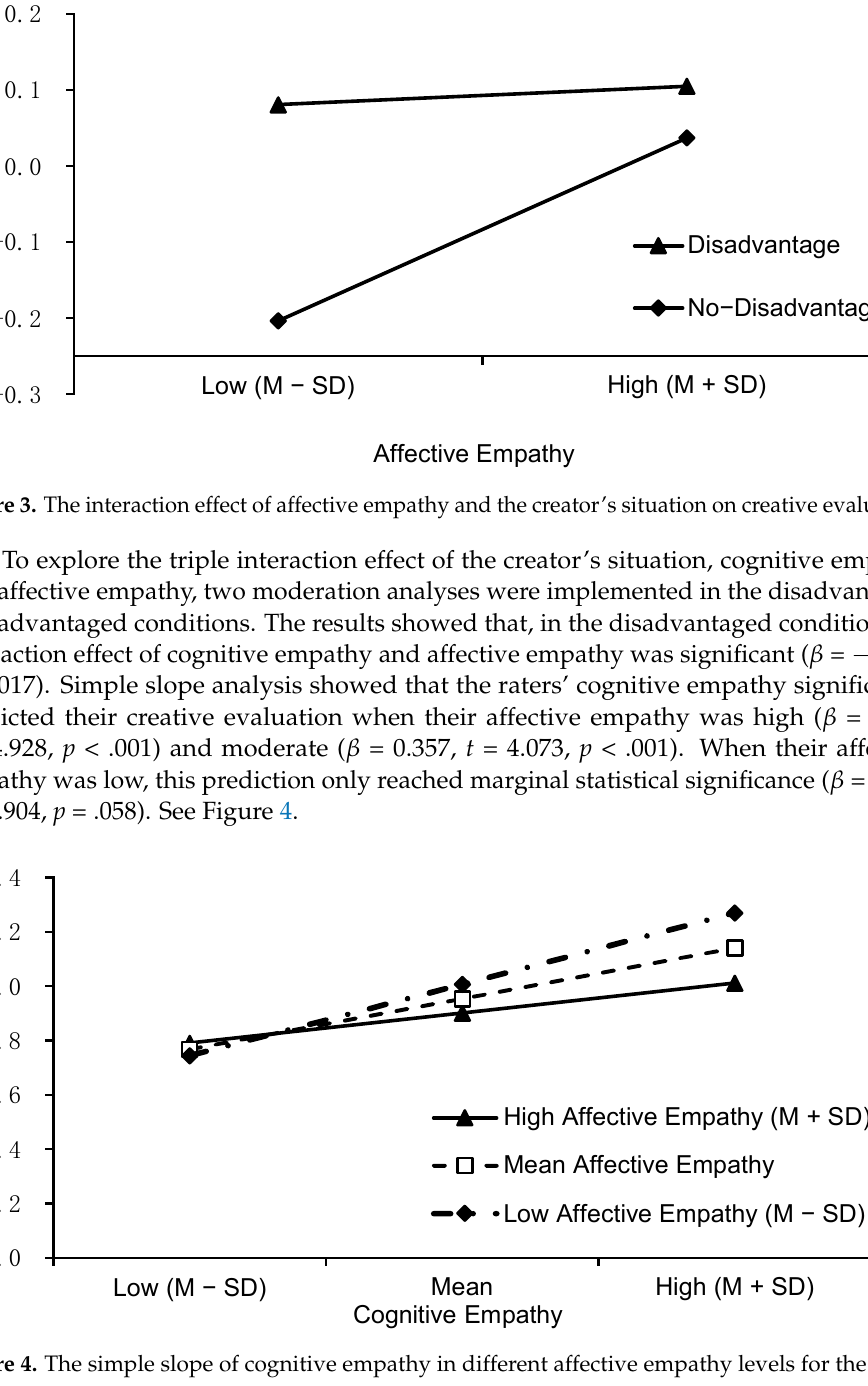
Figure 2. The interaction effect of cognitive empathy and the creator’s situation on creative evalua- tion.